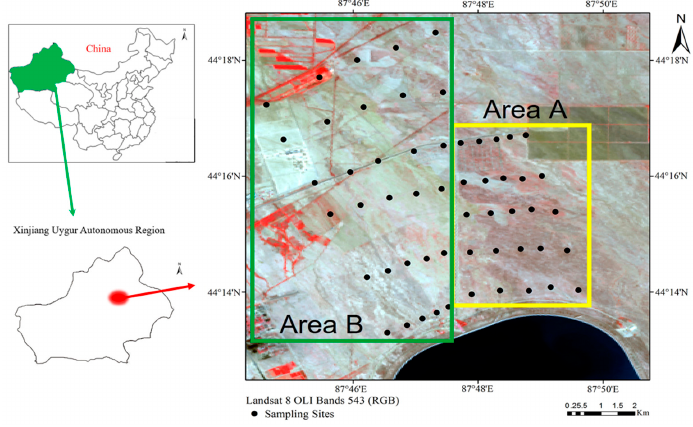
Figure 1. Research areas and locations of the observation points.